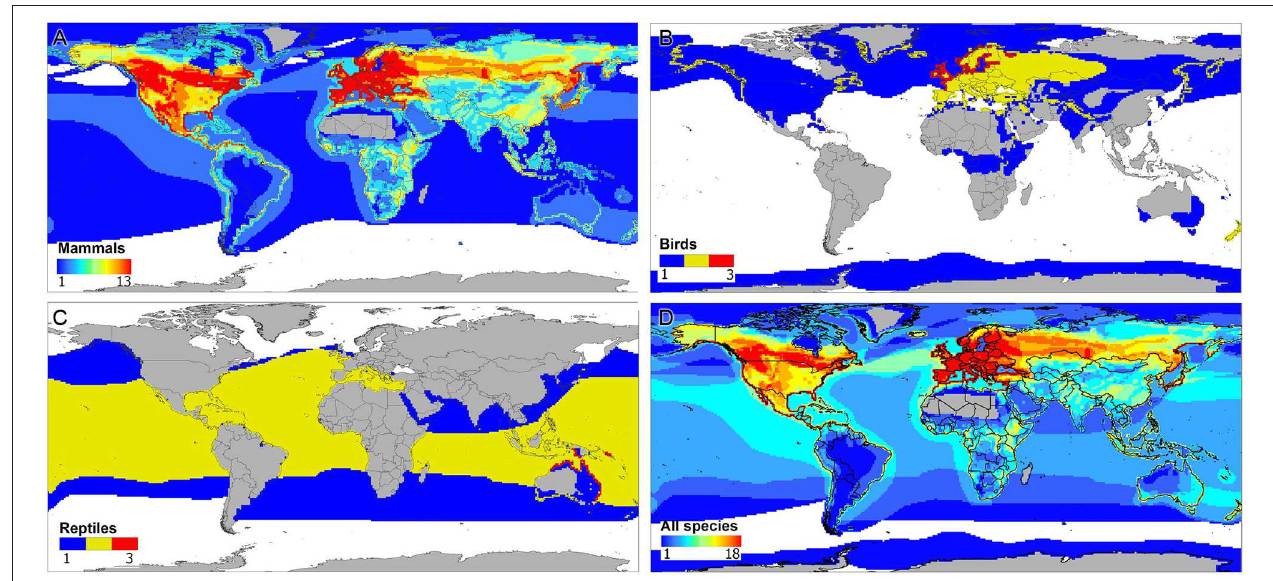
FIGURE 2 | Geographic distribution of wildlife hosts of papillomavirus (WPV). Maps show areas with high (red), moderate (yellow), and low (blue) numbers of WPV hosts species. (A) Mammals. Note that WPV-infected mammals have been reported in the Americas, Europe, Asia, Africa, and Oceania. According to the observations, hotspots of host mammals is expected in the northern Hemisphere. (B) Birds. Note that WPV-infected birds have been reported in coastal areas of the Antarctic and Europe, with considerable overlap of species in northern Europe. (C) Reptiles. Only three reports were found for WPV in reptiles, two turtle species and one snake. (D) Overall distribution of WPV hosts with WPV genomes reported in the literature. Note that most field records of WPV-infected animals are clustered in the northern Hemisphere, resulting in a high richness of WPV hosts in the United States and Canada in North America and in central-western